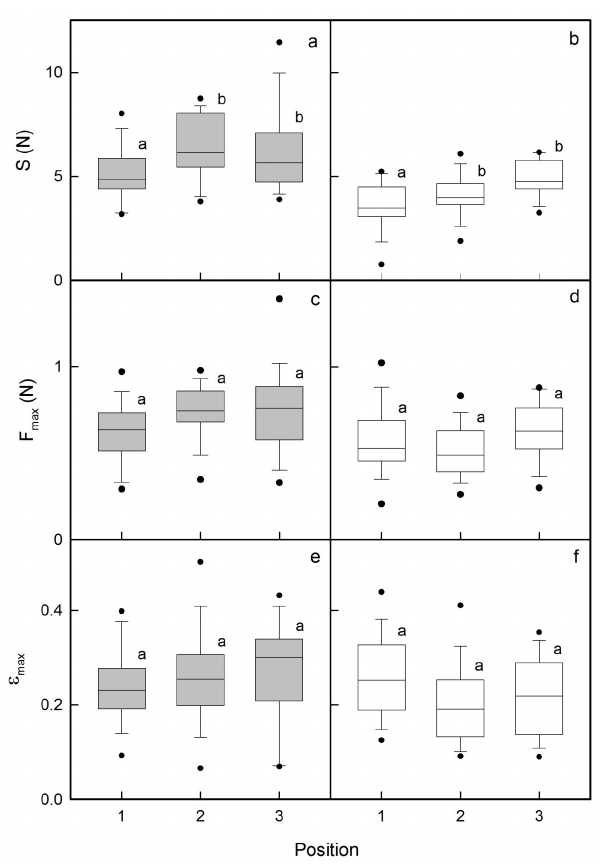
Fig. 4: Stiffness (S) (a, b), maximum force (F max ) (c, d) and maximum strain ( ε max ) (e, f) of internodes (a, c, e) and nodes (b, d, f) of Chara coral- lina as affected by the position along the stem (counted from top, see Fig. 1 a). Means followed by the same letter do not differ signifi - cantly, P <